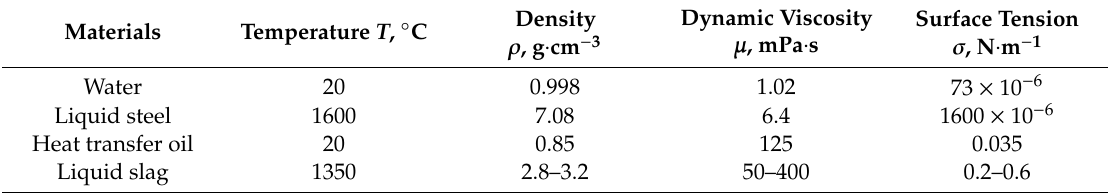
Table 1. Physical properties of the experimental materials and prototype